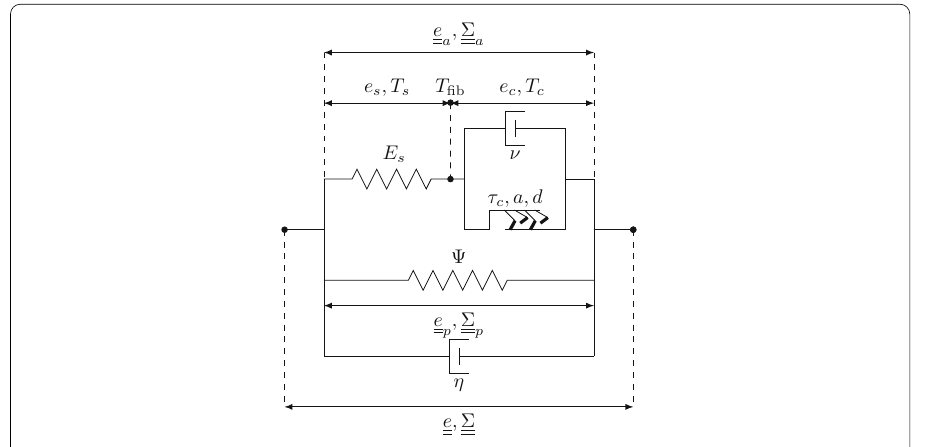
Fig. 5 Fiber rheology combining a 1D active element (upper branch) and a 3D visco-hyperelastic element (lower branch)